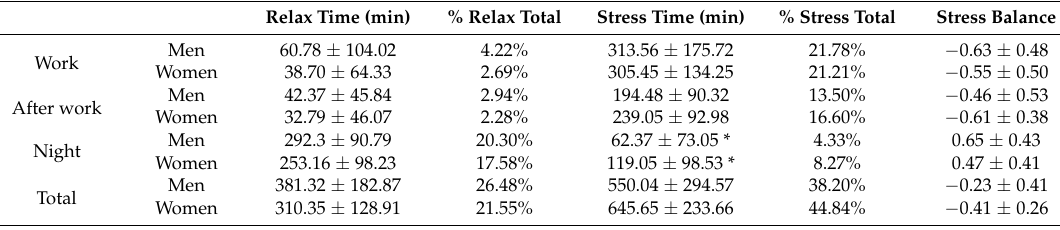
Table 3. Descriptive analysis of the physiological load and recovery segmented by sex (Med ±